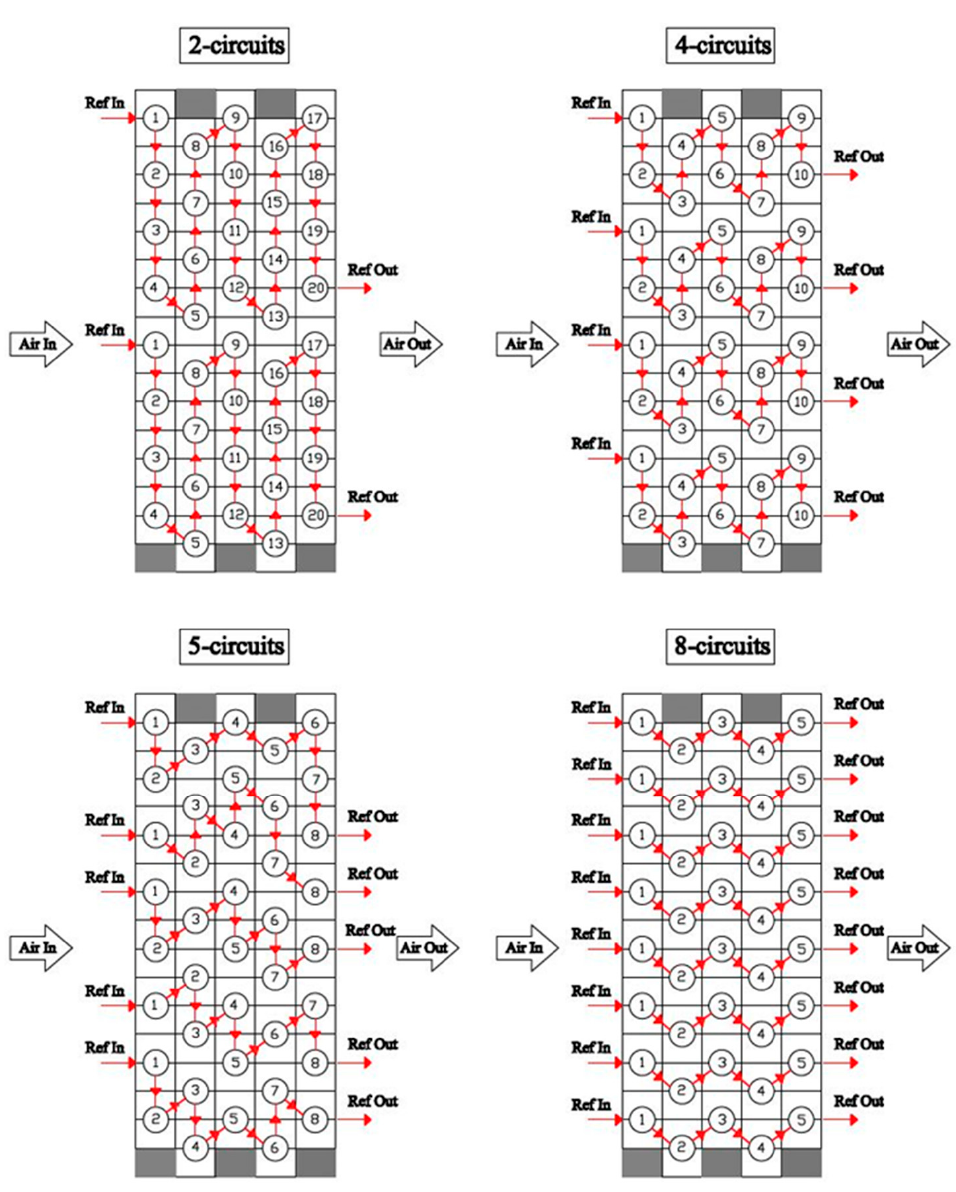
Figure 17. Tested circuitry layouts [88].